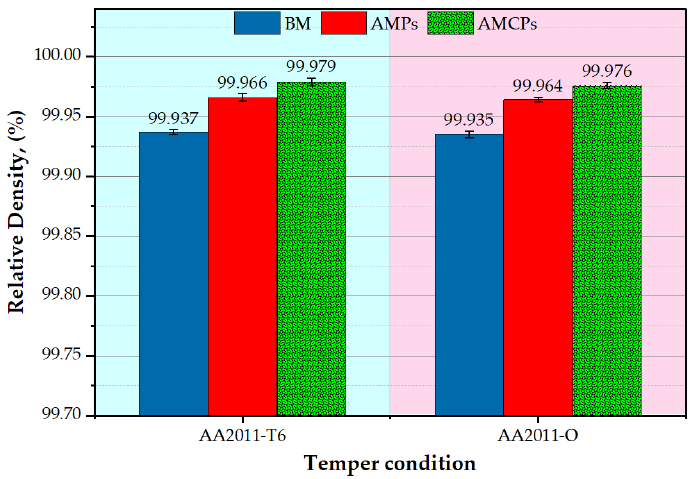
Figure 15. The relative density of the BM, AMPs, and